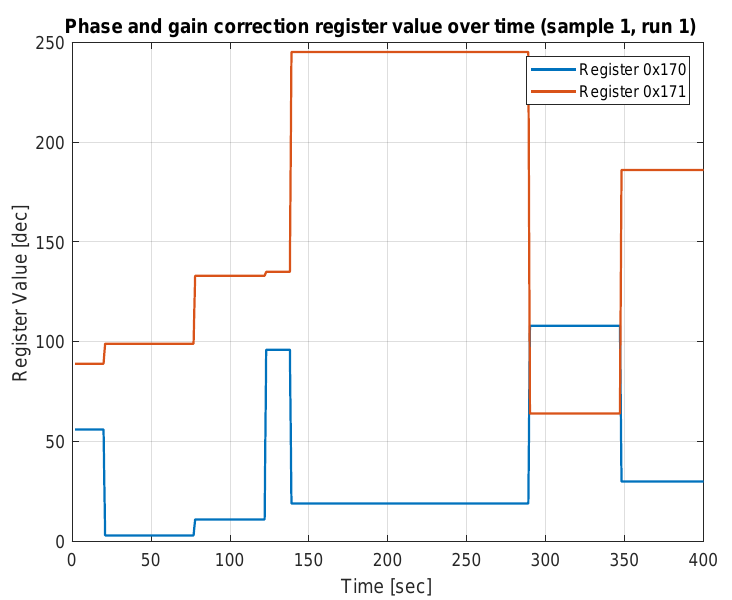
Figure 11. Masked configuration register (0x170 and 0x171) for gain and phase